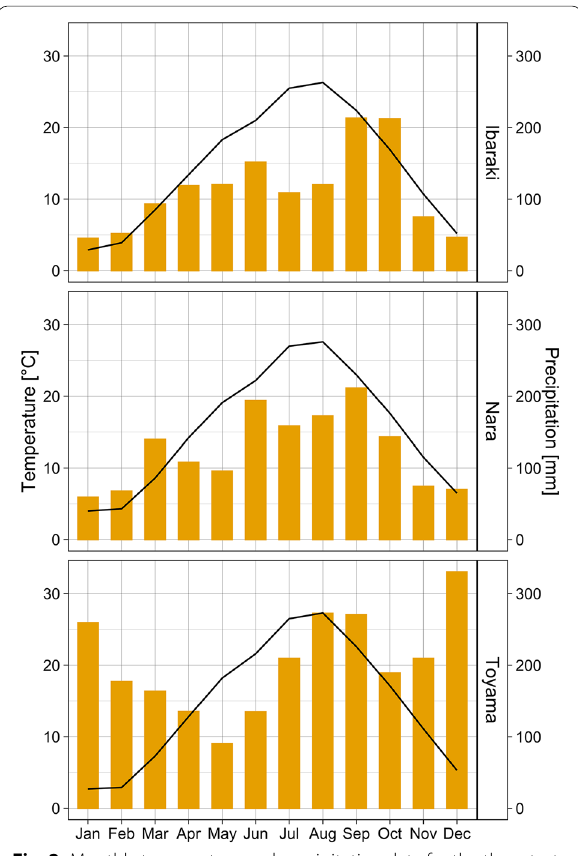
Fig. 2 Monthly temperature and precipitation data for the three test sites. Temperature, −